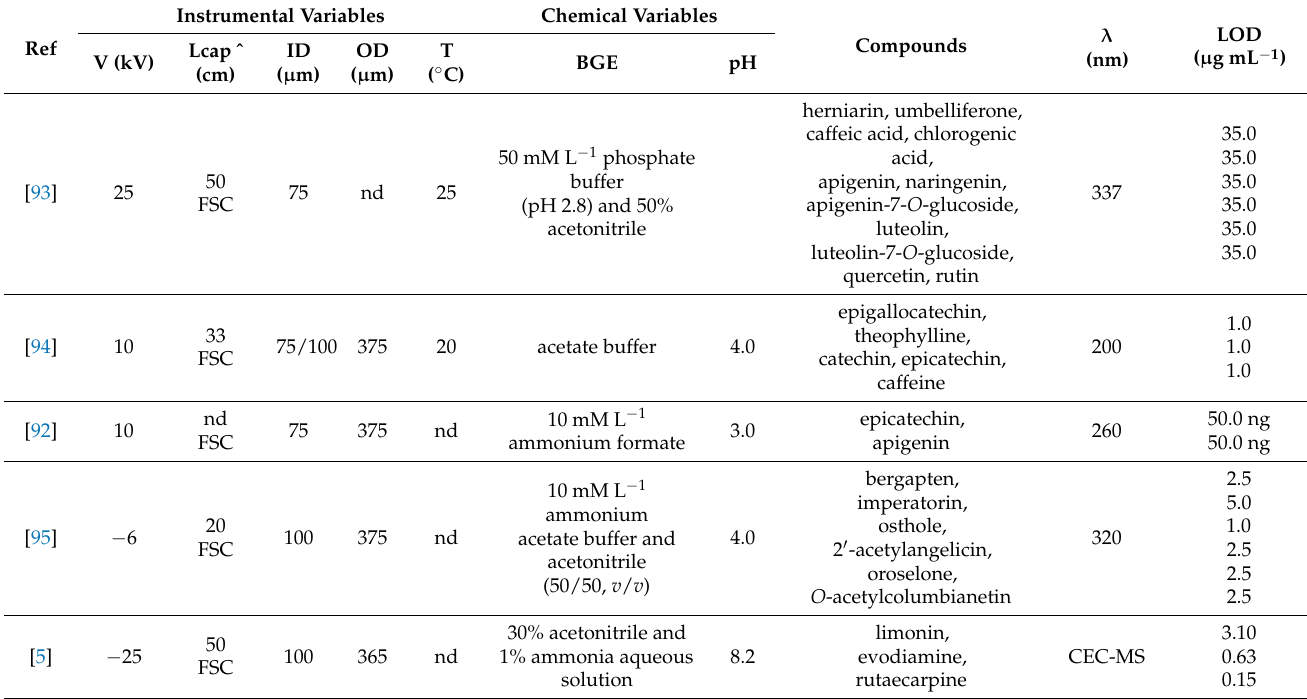
Table 7. Process of separation of analytes with application capillary electrochromatography.